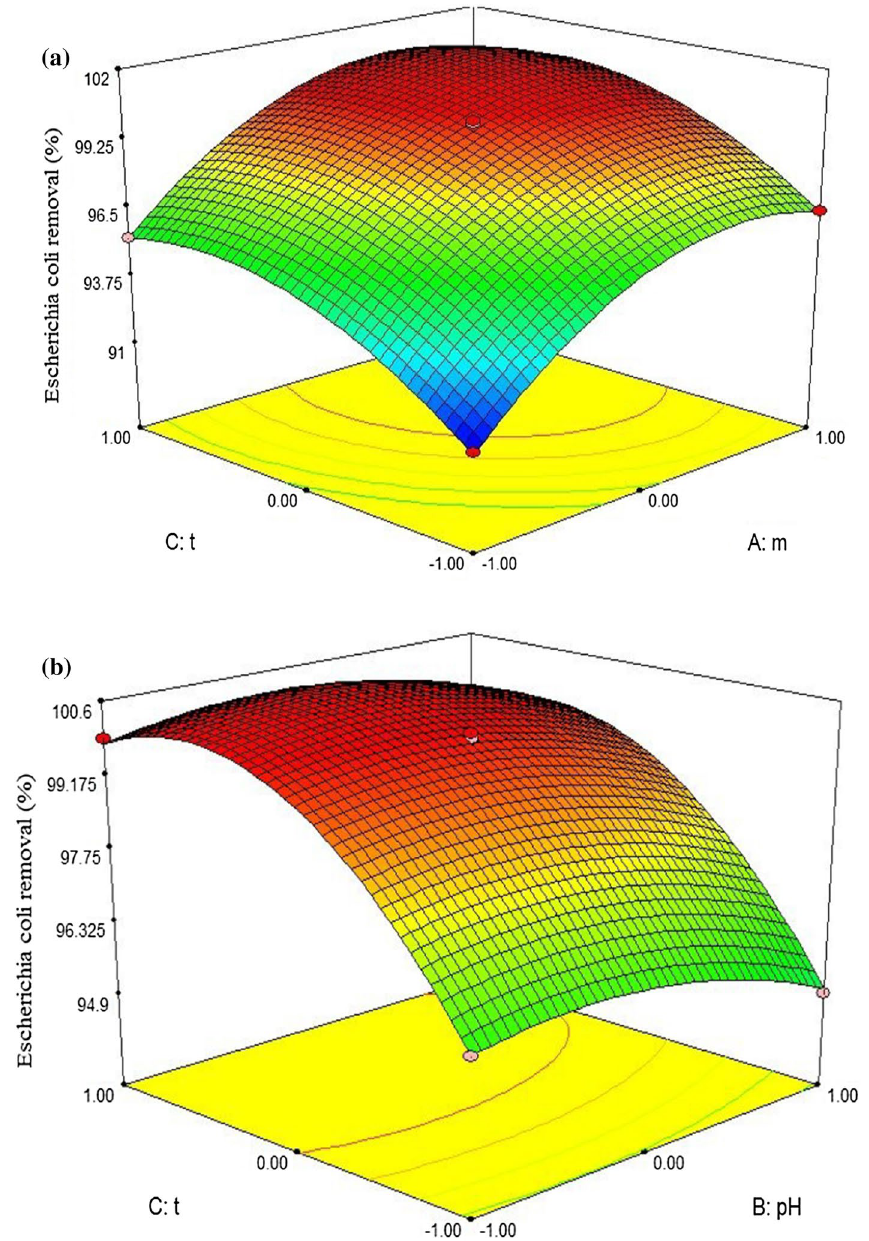
Fig. 4 3D diagram of changes in Escherichia coli removal rate in terms of code and actual values; a nanoparticles dosage and contact time; b pH and contact